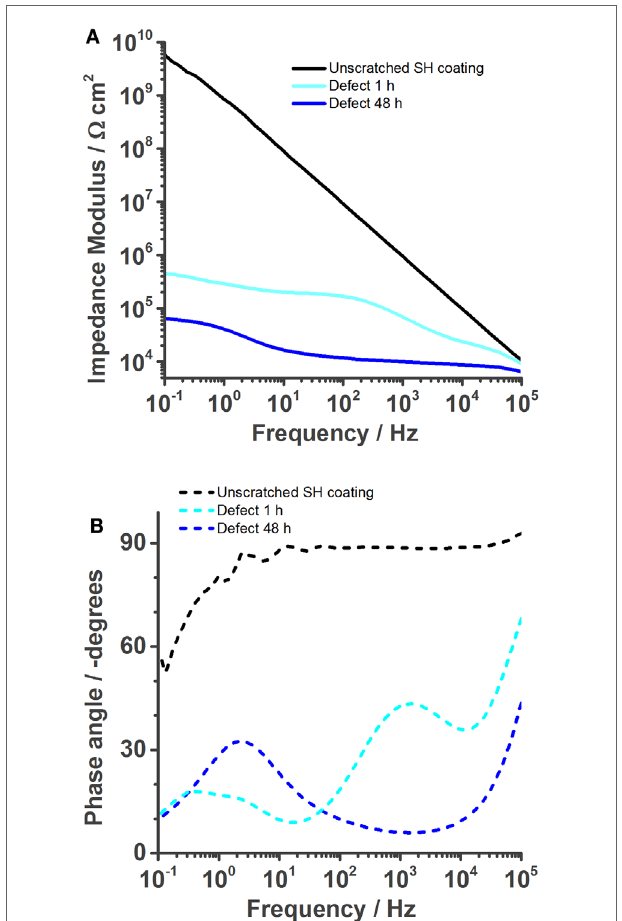
FigUre 4 | Bode plots of the self-healing reference coating without corrosion inhibitor immersed in 0.05 M nacl solution . The undamaged coating shows good barrier properties. (a) But once a defect is inflicted into the coating, its impedance is strongly reduced (1 h) and further decreases over time (48 h). The phase plot (B) shows the various time